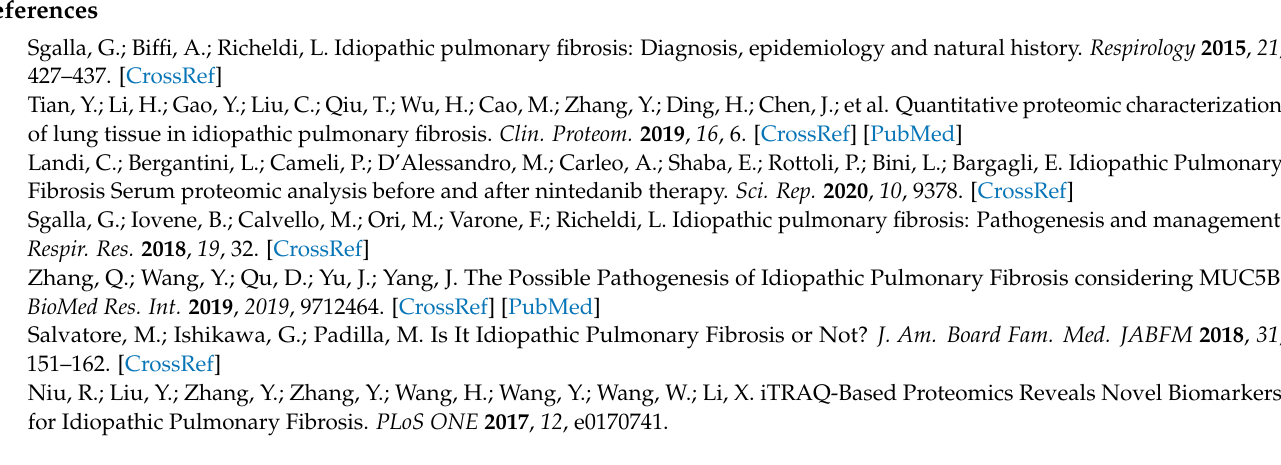
comparisons, Table S9: GO enrichment (biological process) for up-regulated proteins in the pairwise comparisons using GeneCodis, Table S10: GO enrichment (biological process) for down-regulated proteins in the pairwise comparisons GeneCodis, Table S11: GO enrichment (molecular function) for up-regulated proteins in the pairwise comparisons using GeneCodis, Table S12: GO enrichment (molecular function) for down-regulated proteins in the pairwise comparisons using GeneCodis, Table S13: GO enrichment (cellular component) for up-regulated proteins in the pairwise comparisons using GeneCodis, Table S14: GO enrichment (cellular component) for down-regulated proteins in the pairwise comparisons using GeneCodis, Table S15: Enrichment pathways (KEGG) for up-regulated proteins in the pairwise comparisons using GeneCodis, Table S16: Enrichment pathways (KEGG) for down-regulated proteins in the pairwise comparisons using